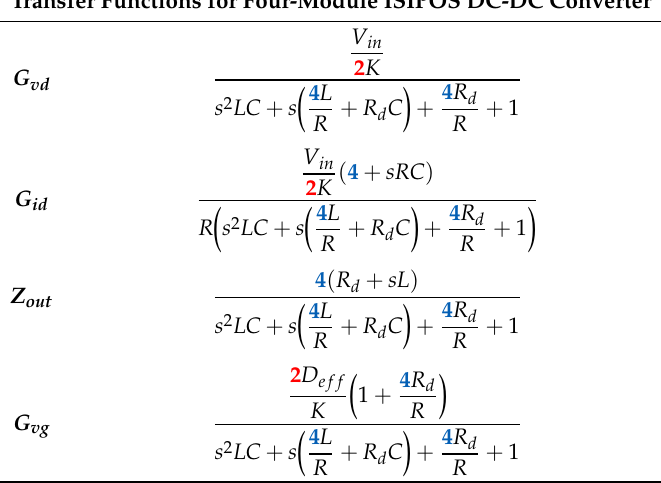
Table 7. Generalized model verification with the four-module ISIPOS power